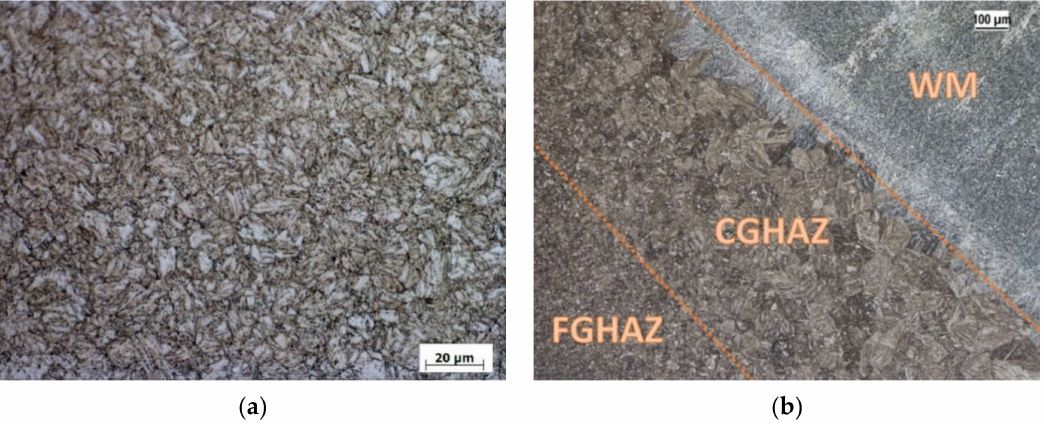
Figure 8. ( a ) The microstructure of the base material S960 QL, enlarged 500 × , etched by Nital 2%. ( b ) The micro-structure of the transition of the welded metal to HAZ on the material S960 QL welded by the MAG technology: WM—weld metal, CGHAZ—coarse grain HAZ, FGHAZ—fine grain